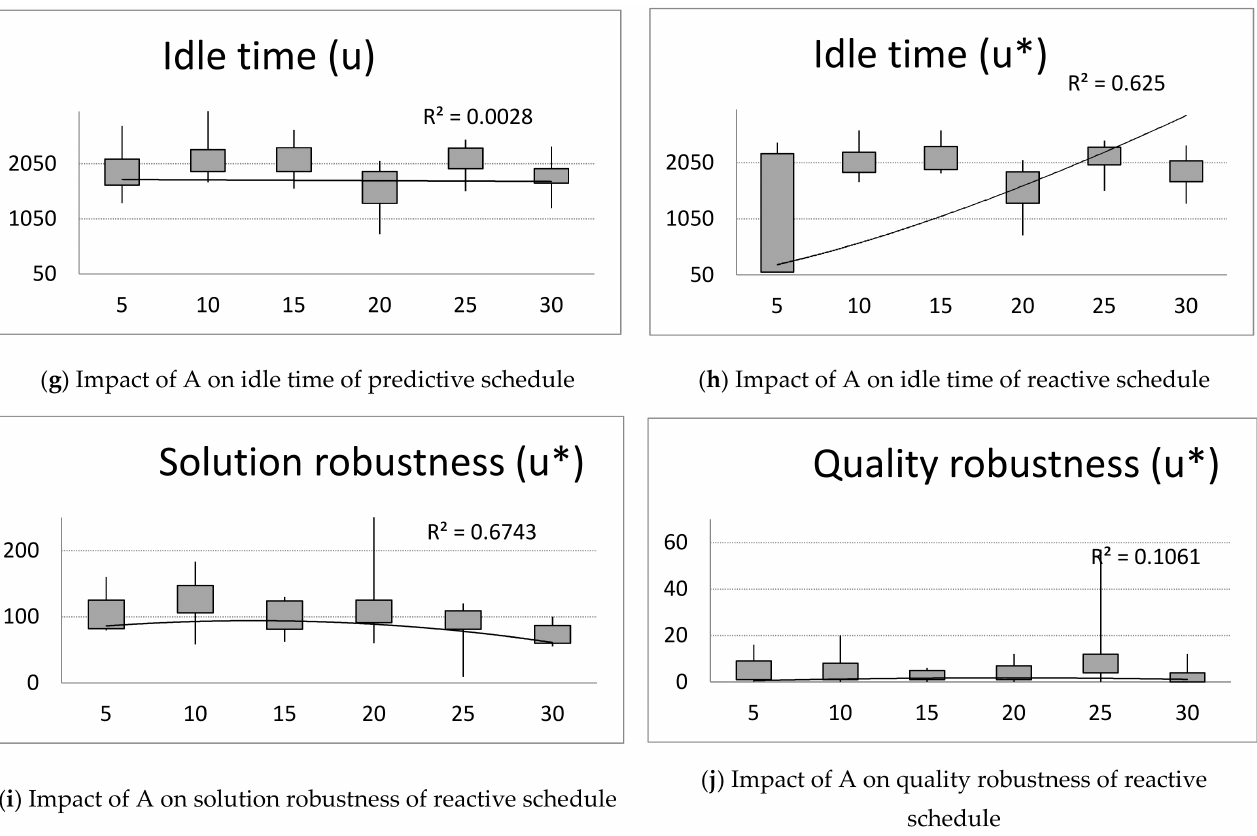
Figure 3. The impact of number of ants, A = {5, 10, 15, 20, 25, 30}; on makespan, flow time, total tardiness, and idle time of predictive schedules (u) and reactive schedules (u*) and solution robustness and quality